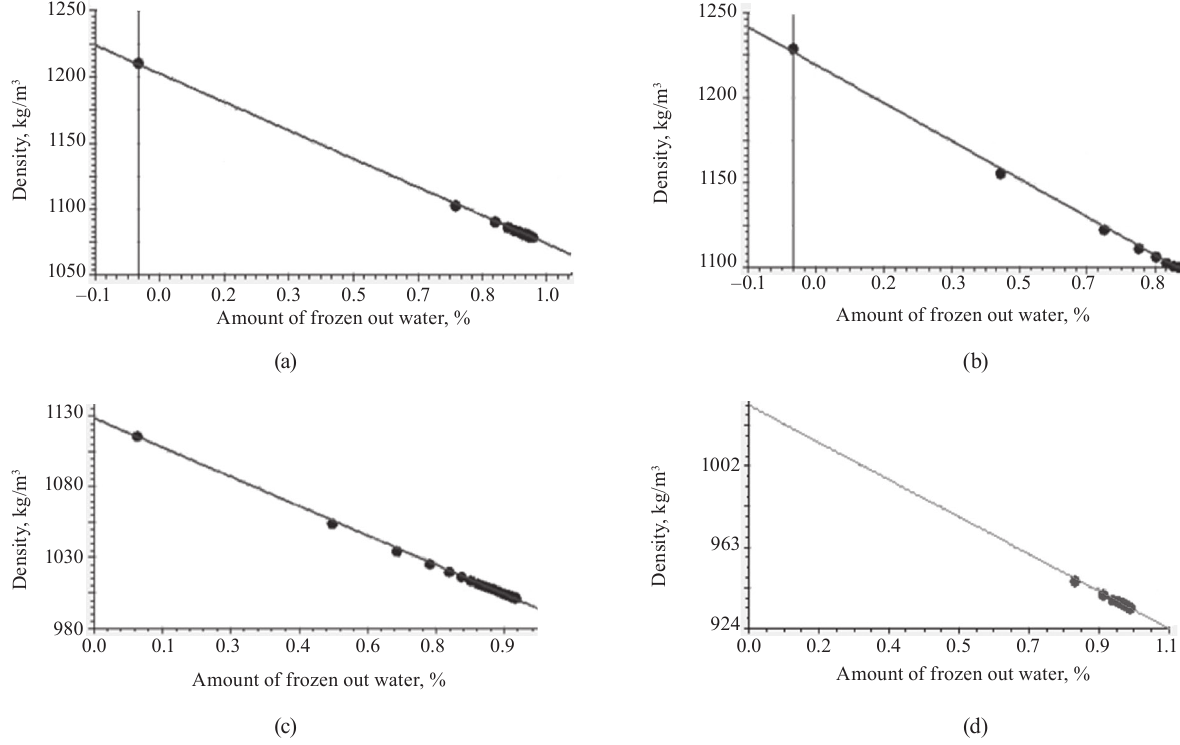
Figure 3 Relation between the density and the amount of frozen out water for: (a) milt of Pacific herring; (b) pallium of squid; (c) octopus skin; (d) cucumaria